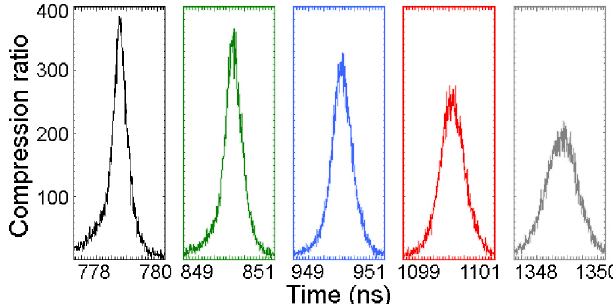
(cid:2) t (cid:3) =I comparison using b 0